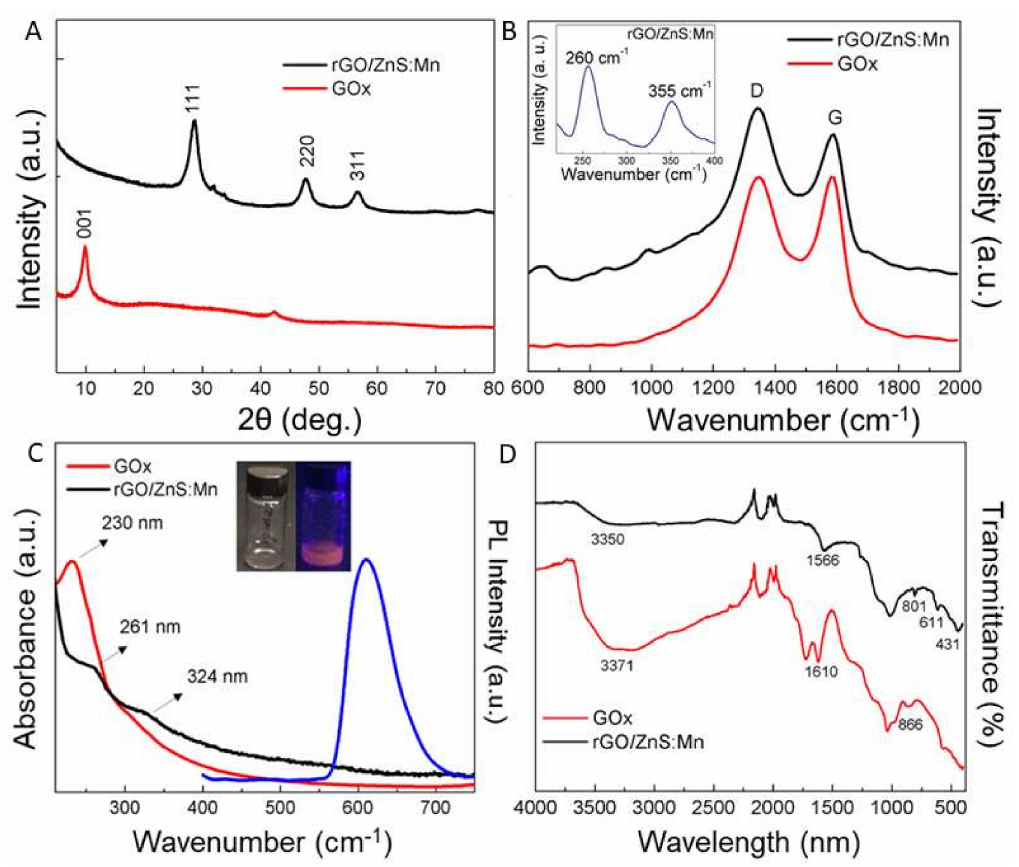
Figure 2. ( A ) XRD patterns; and ( B ) Raman; ( C ) UV/PL; and ( D ) FT-IR spectra of GOx and FA-rGO/ZnS:Mn. Inset in ( B ) shows the low-frequency Raman spectrum of ZnS:Mn. Inset in ( C ) shows the optical images of FA-rGO/ZnS:Mn in absence and presence of UV light (365